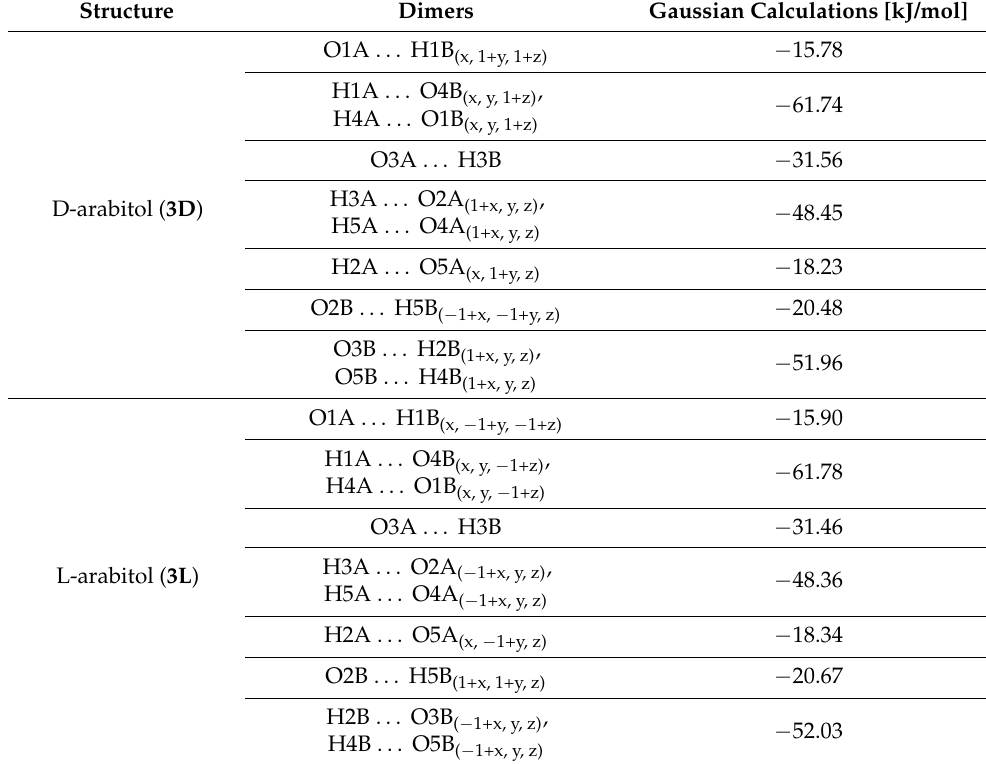
Table 2. Dimer energy calculations using M06-2X/cc-pVDZ for D-arabitol and L-arabitol by counter- poise method in Gaussian09. Symmetry operations are given in parenthesis. Dimers O3A . . . H3B are formed within asymmetric